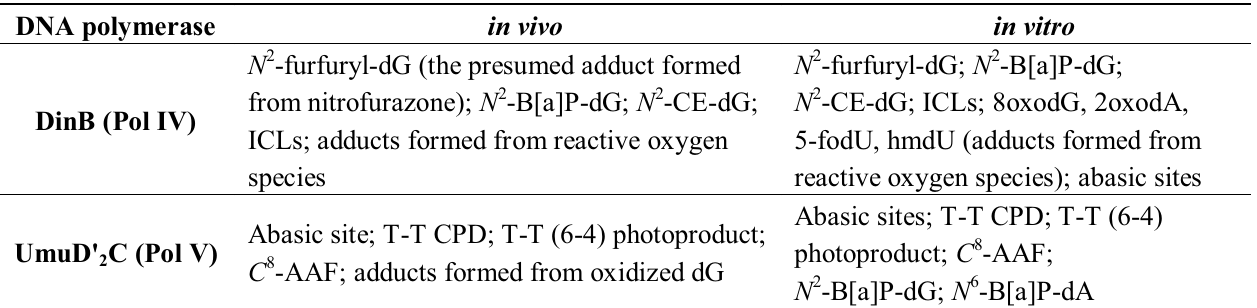
Table 1. Comparison of adducts bypassed in vitro and in vivo by DinB or UmuD' Relevant references and abbreviations are listed in the text. DNA